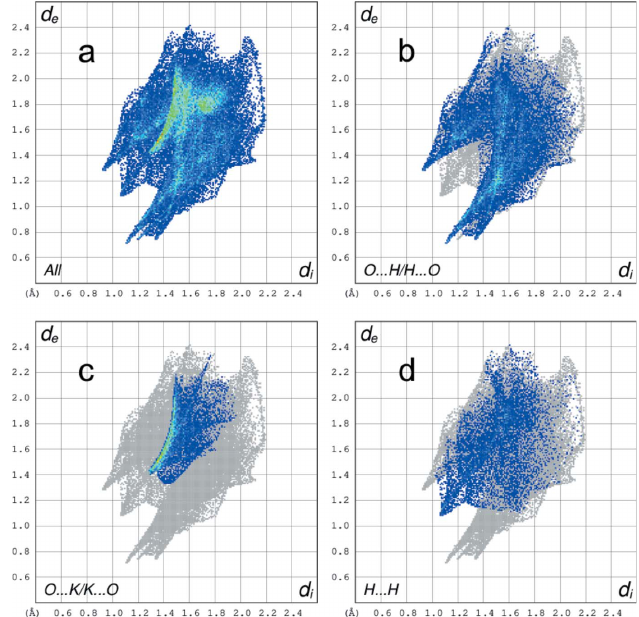
Figure 10 ( a ) Full two-dimensional fingerprint plot of the B complex anion (Ni1 B ), and delineated into ( b ) O (cid:2)(cid:2)(cid:2) H/H (cid:2)(cid:2)(cid:2) O (41.0%) ( c ) O (cid:2)(cid:2)(cid:2) K/K (cid:2)(cid:2)(cid:2) O (15.8%) and ( d ) H (cid:2)(cid:2)(cid:2) H (15.1%)